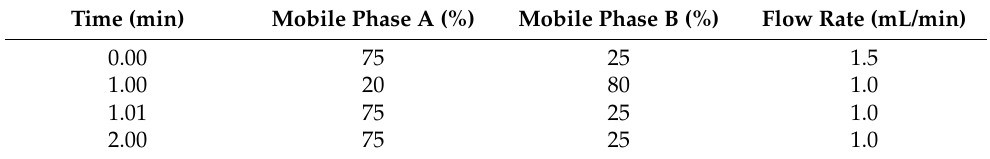
Table 1. HPLC mobile gradient profile.